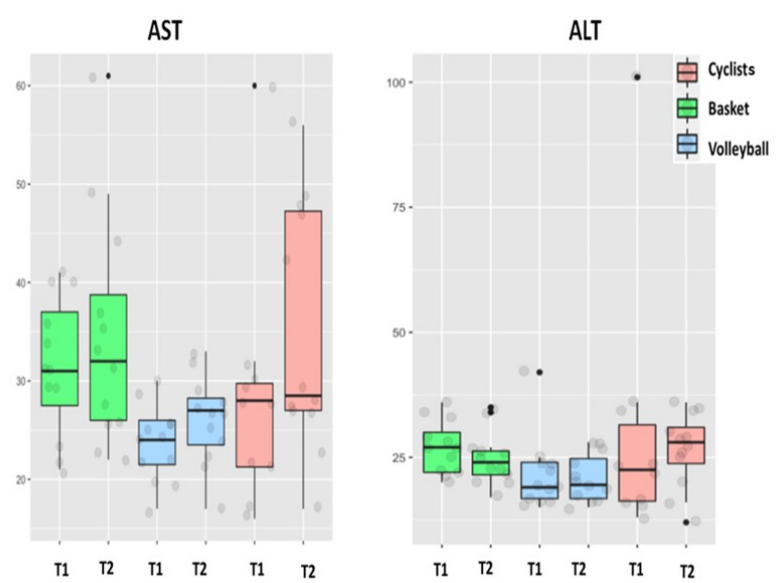
Figure 4. Aspartate aminotransferase (AST) and alanine aminotransferase (ALT) (IU/L) levels in cyclists, basketball and volleyball players at the end of T1 and T2.